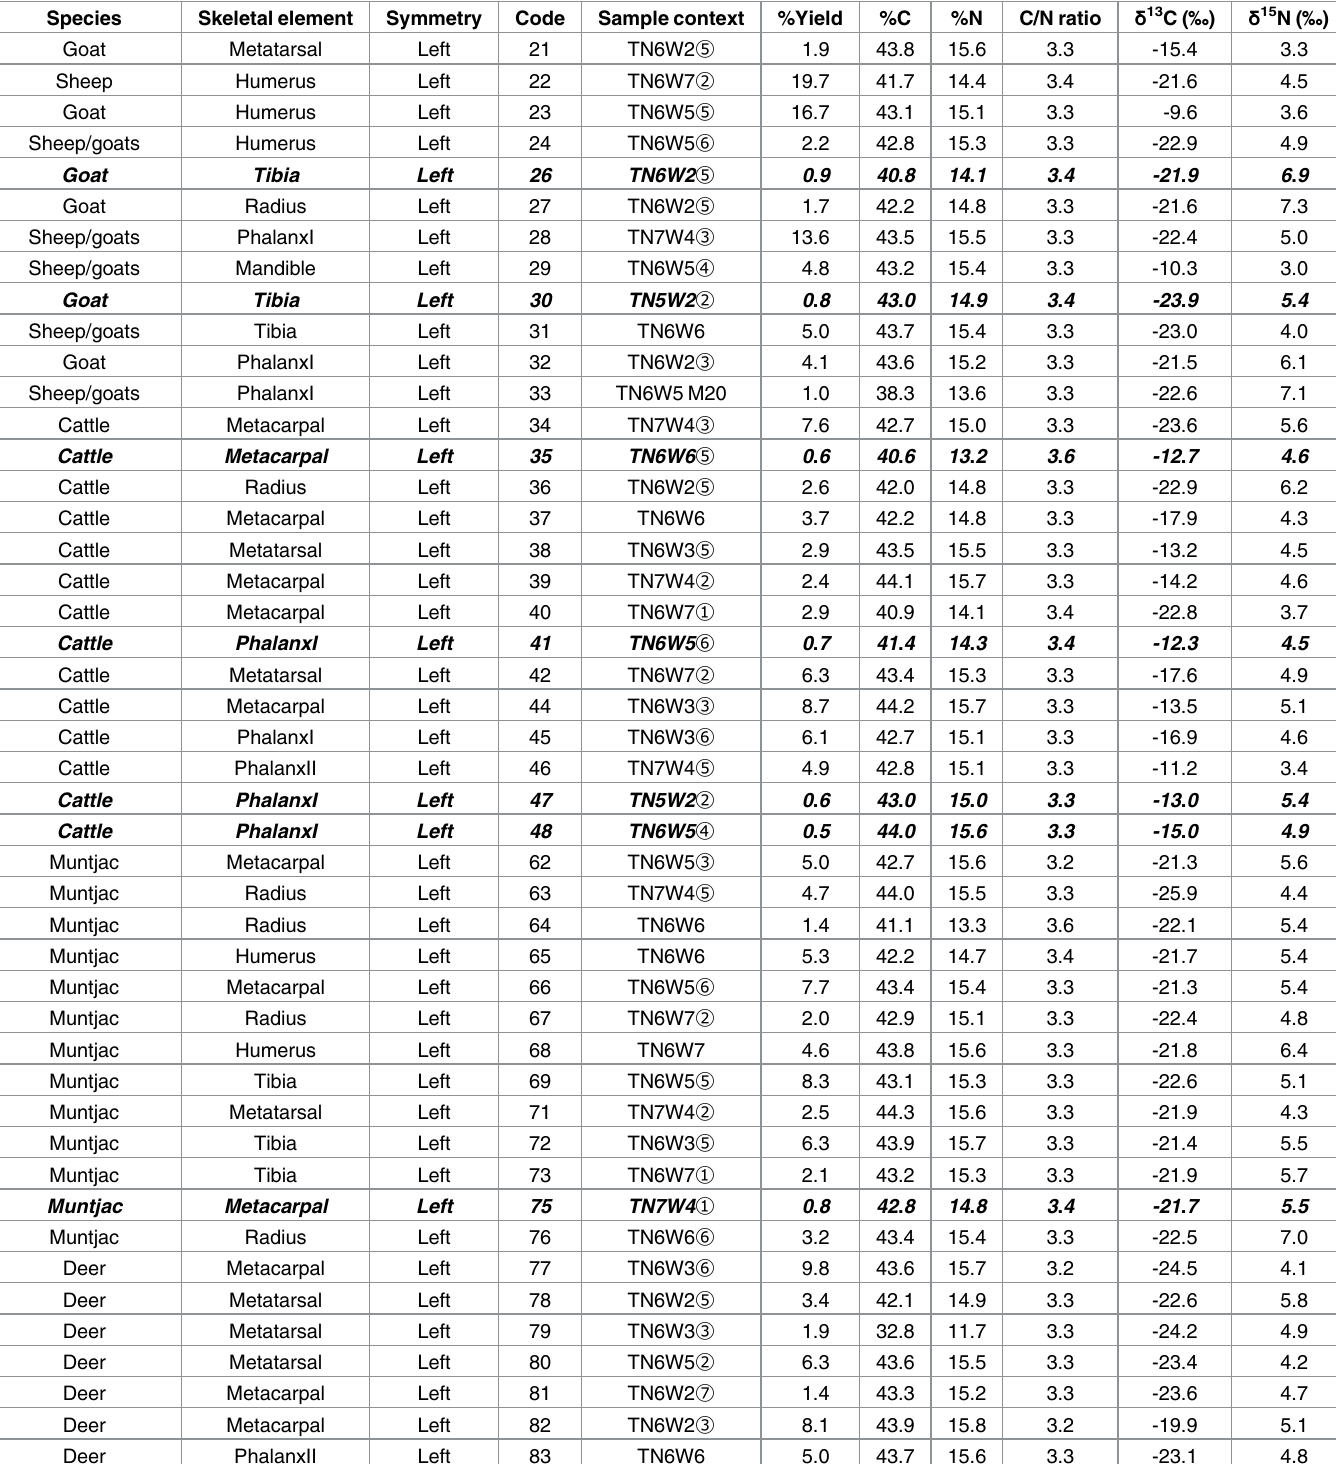
Table 1. Isotopic composition and quality indicators of animal samples from Shilinggang, Yunnan. Samples marked in bold italics were found to be contaminated, and were not includedin further statistical analysis. Context locationsare shown in Fig 2a. Among the sample context codes, TNnWn (where n is an Arabic numeral) refers to excavationunit; circles with a numberinside refer to the